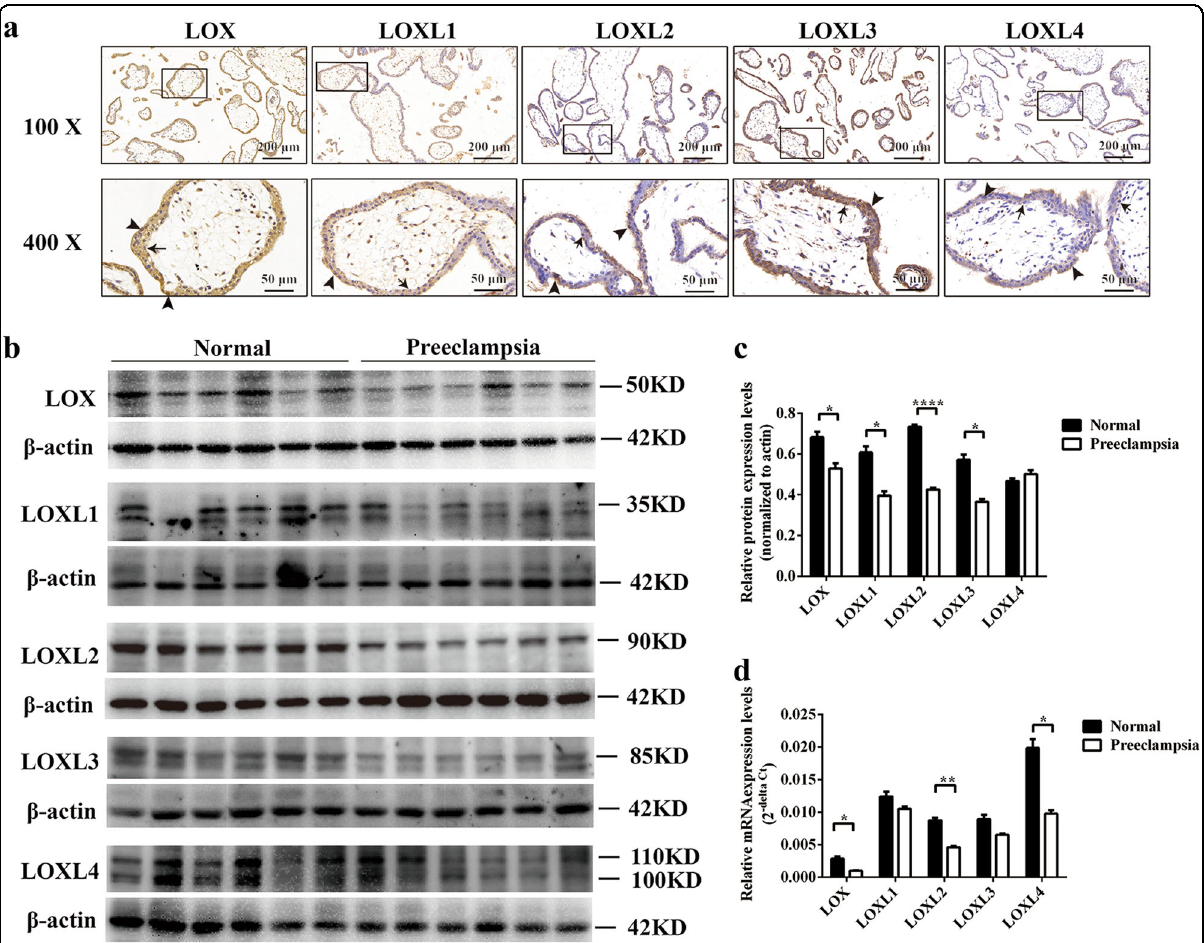
Fig. 1 Decreased expression of LOX and LOXL2 was found in preeclamptic placentas. a Representative images of expression and localization of LOX family members in fi rst trimester villi by immunohistochemistry analysis. Brownish color represents positive staining of LOX family members. Arrows, trophoblasts; arrowheads, cytotrophoblasts. b Western blot analysis of LOX family members in placentas from normal full-term pregnancies and preeclampsia patients. c Statistical analysis of protein densitometry quanti fi cation of western blot analysis ( b ) by Student ’ s t -test. Data are presented as the means ± SEM. d mRNA expression of LOX family members was analyzed by quantitative reverse-transcription PCR. Statistical data were analyzed by Student ’ s t -test. Data are presented as the means ± SEM. * P < 0.05; ** P < 0.01; and **** P <